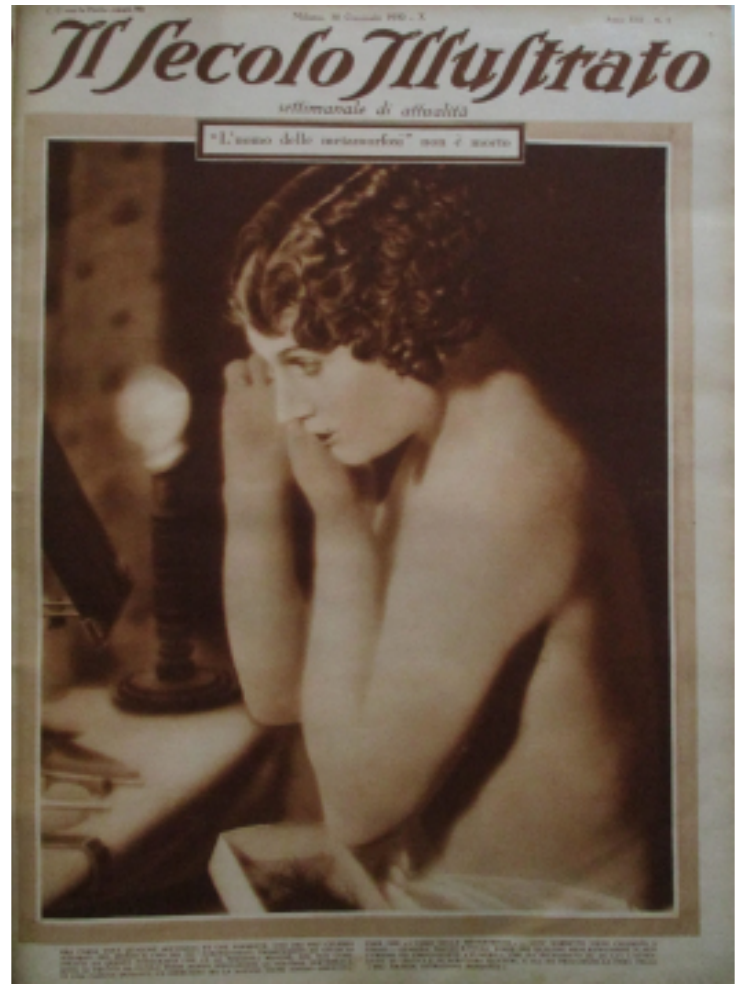
Fig. 3 ‘“L’uomo delle metamorfosi” non è morto’, Il Secolo Illustrato , 21.5 (30 January 1932),